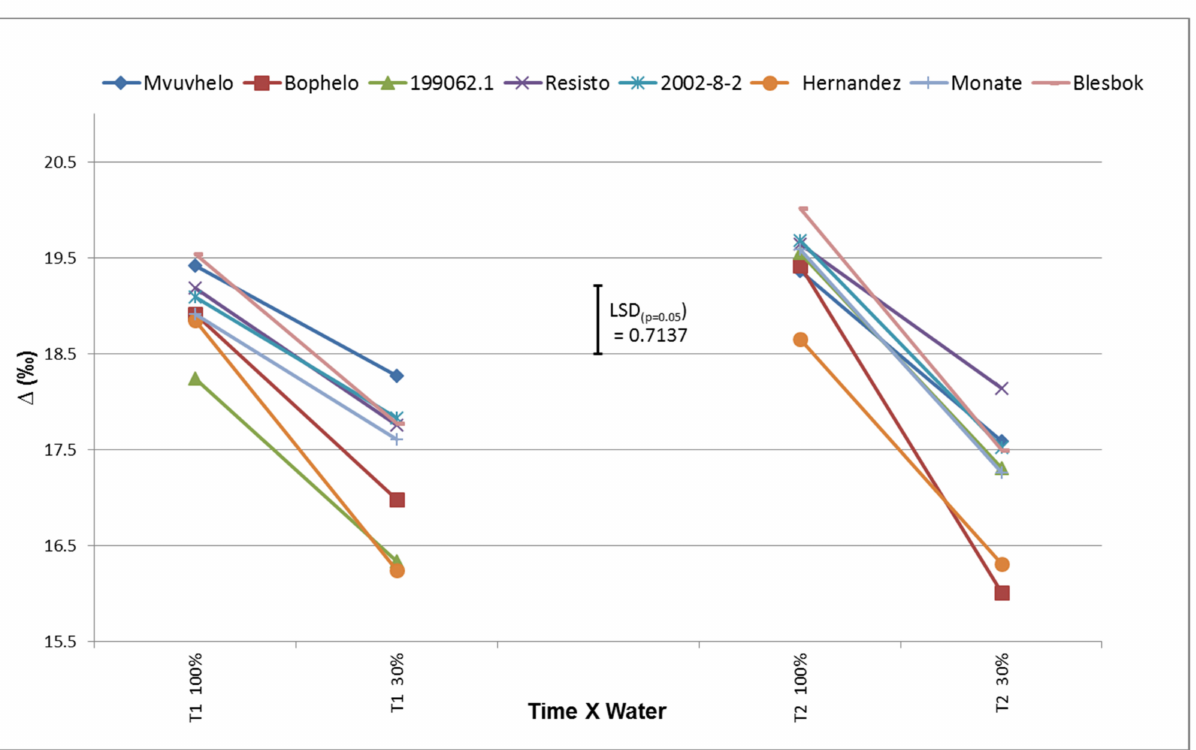
Figure 7. 13 C isotope discrimination ( ∆ 13 C) values in leaves of eight sweet potato cultivars subjected to drought and control conditions in Trial 3. LSD = 0.7137; T1 = 60 days after planting; ( p = 0.05) T2 = 120 days after planting. 100% = control treatment; 30% = severe stress treatment. Each value is the mean of 3 measurements with 3 repeats per